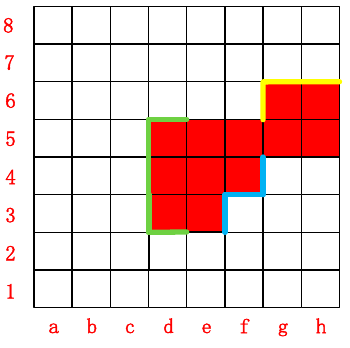
Figure 3. Process of the classification of the aliasing pattern.